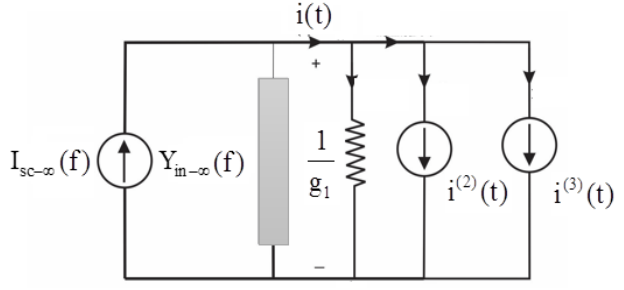
FIGURE 3. Equivalent circuit of figure 2 based on the NC technique.